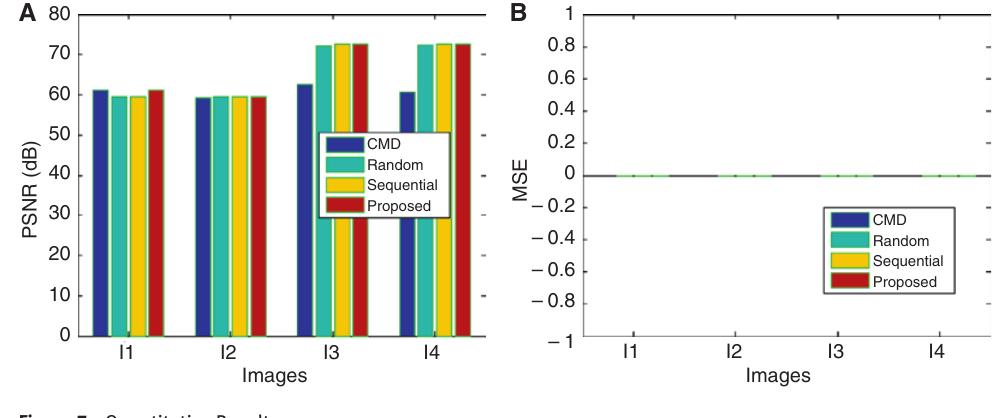
Figure 7: Quantitative